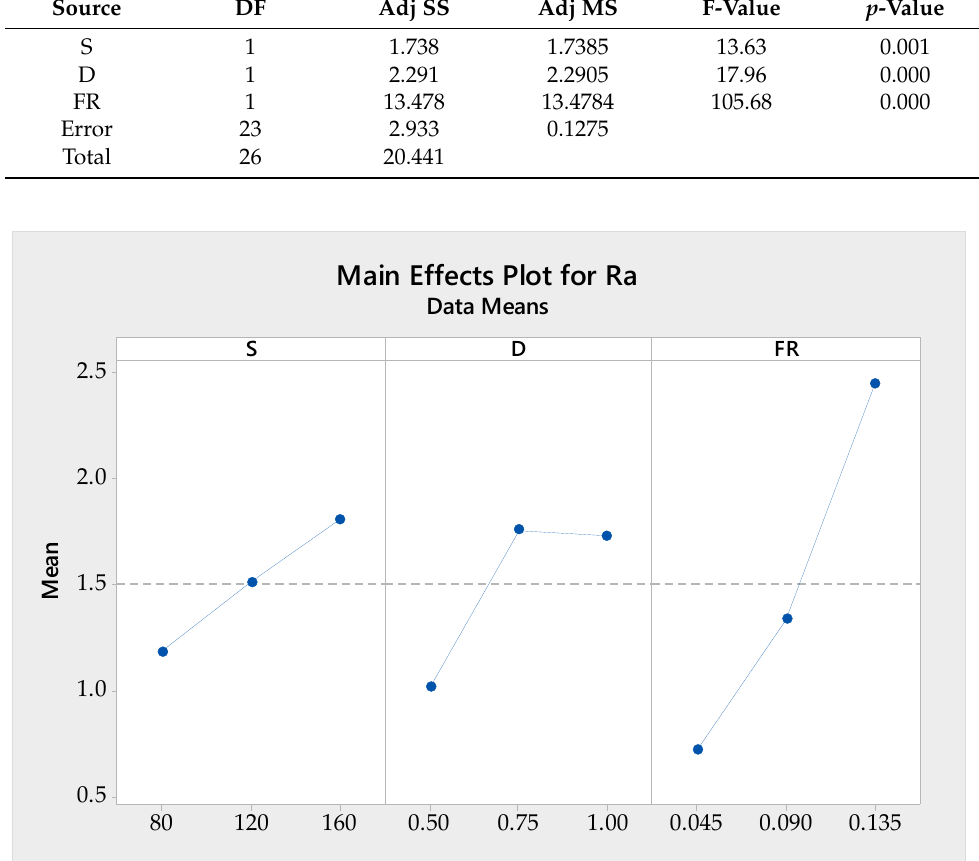
Figure 9. Main effect plots for Ra using conventional edge.